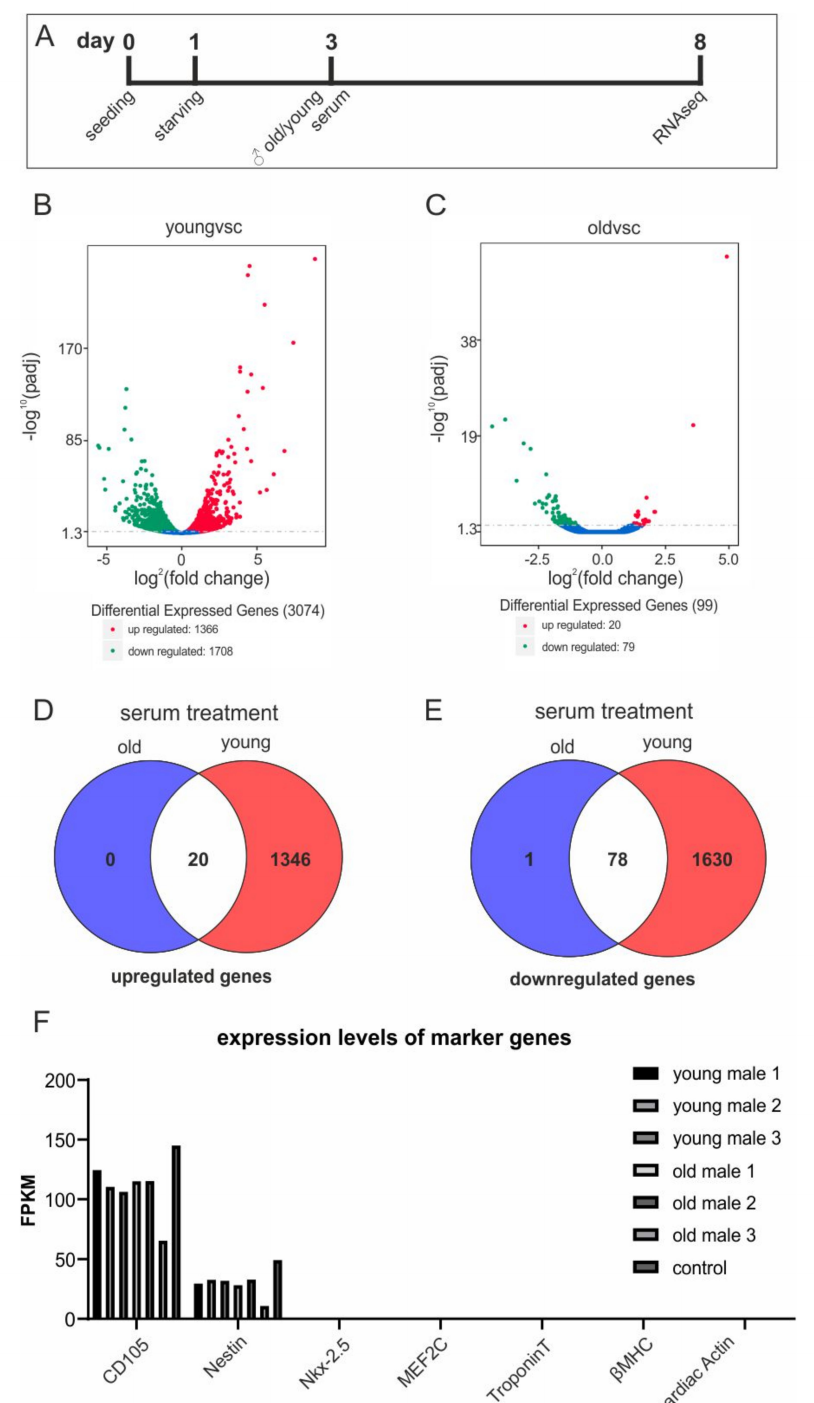
Figure 4. RNAseq showed increased differential gene expression in an age-dependent manner. ( A ) hCSCs where exposed to blood serum and blood plasma from old ( > 60 years) and young ( < 20 years) male donors or starvation medium followed by RNAseq. ( B ) Volcano plot of differential expressed genes in hCSCs treated with young serum vs. control. ( C ) Volcano plot of differential expressed genes in hCSCs treated with old serum vs. control. Red: upregulated; green: downregulated genes. A detailed list is provided in Supplementary Table S1. ( D ) Venn diagram of upregulated genes in the old and young treatment groups. ( E ) Venn diagram of downregulated genes in the old and young treatment